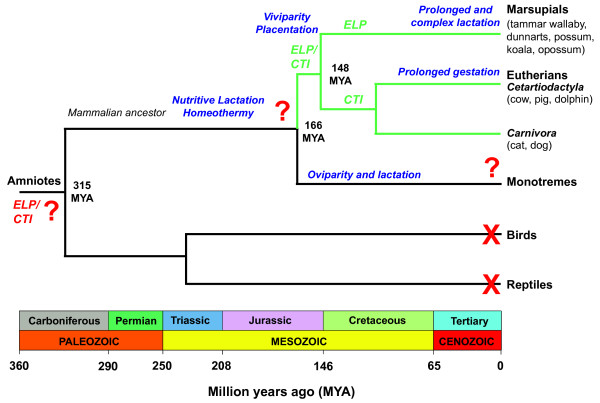
Evolution of theELP/CTIgene in therians. Tree depicting the relationship between the amniotes: birds, reptiles, monotremes, marsupials and eutherians [1,3,70,71] and the distribution of the ELP/CTI gene. The divergence times used are based upon the analysis by Bininda-Emonds and colleagues [1]. Extant species which have a functional ELP/CTI gene are indicated by green tree branches. Extant species in which the ELP/CTI gene has not been detected are indicated by a red cross. Lineages on the tree for which the presence or absence of the ELP/CTI gene remains inconclusive are indicated by a red question mark. Based upon current analyses, the functional ELP/CTI gene evolved at least 130 million years ago (MYA) and has been retained by extant marsupials and the Laurasiatherian orders Cetartiodactyla and Carnivora. Whether the ELP/CTI gene is present in monotremes is unknown.